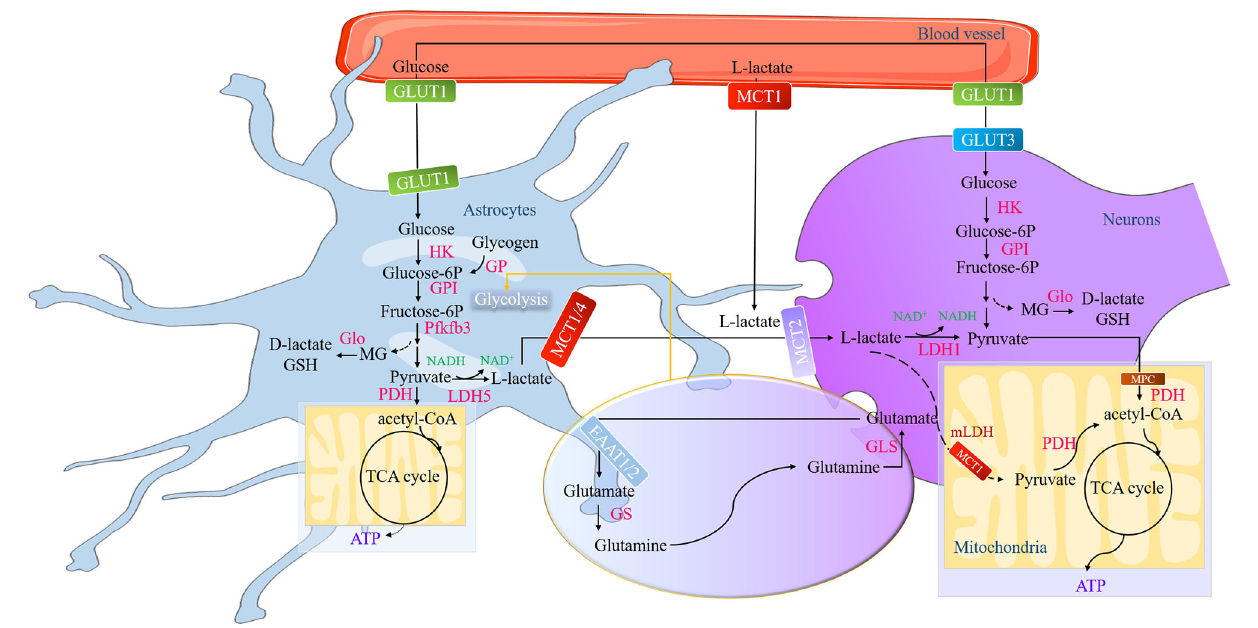
FIGURE 1 | The formation and metabolism of lactate in the brain. The action of the glutamate-glutamine cycle switches on the glycolysis in the astrocytes, a process of glutamate released by neuronal terminals and then is taken up by astrocytes via the EAATs to convert into glutamine or GSH. Pfkfb3 (a key positive modulator of glycolysis) is a high expression in astrocytes and low in neurons, while the activity of PDH is low in astrocytes and low in neurons. These characteristics determine that astrocytes have strong glycolysis ability and neurons have strong aerobic oxidation ability. Astrocytic glycogen first decomposes into glucose-6P catalyzed by GP and finally into pyruvate through a series of catalytic reactions. During this process, a tiny amount of MG generates and then converts into endogenic D-lactate or GSH. The newly formed pyruvate can be either converted to acetyl-CoA for the astrocytic TCA cycle or transformed into L-lactate by LDH5. The L-lactate in the astrocytes and in the brain blood vessel is transported into the neurons through MCTs (MCT1, MCT2, and MCT4) and then oxidized at the Krebs cycle. EAATs, excitatory amino acid transporters; GSH, glutathione; Pfkfb3, phosphofructokinase-2/fructose-2,6-bisphosphatase 3; PDH, pyruvate dehydrogenase; Glucose-6P, glucose-6-Phosphate; GP, glycogen phosphorylase; MG, methylglyoxal; acetyl-CoA, acetyl coenzyme A; lactate dehydrogenase 5, LDH5; Monocarboxylic acid transporters,